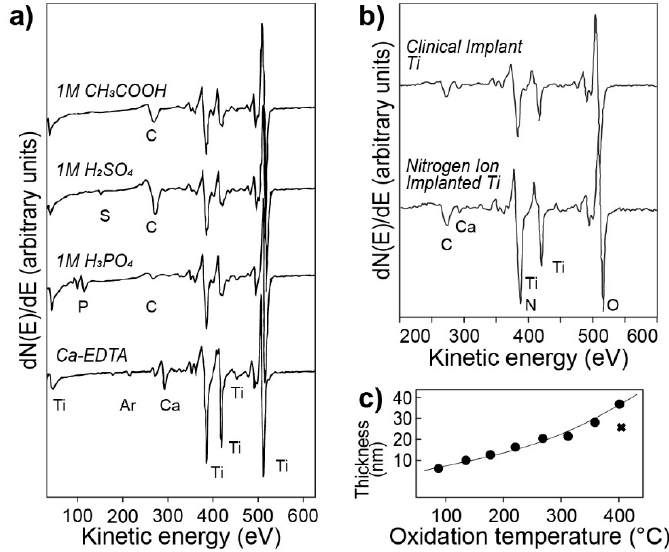
Figure 3. Examples of AES spectra recorded during various experiments. ( a ) Anodic oxides of titanium prepared in several electrolytes, ( b ) comparison between machined (top) and nitrogen ion implanted (bottom) samples, and ( c ) thickness of an oxide layer as a function of temperature. Figure adapted with permission from [39].